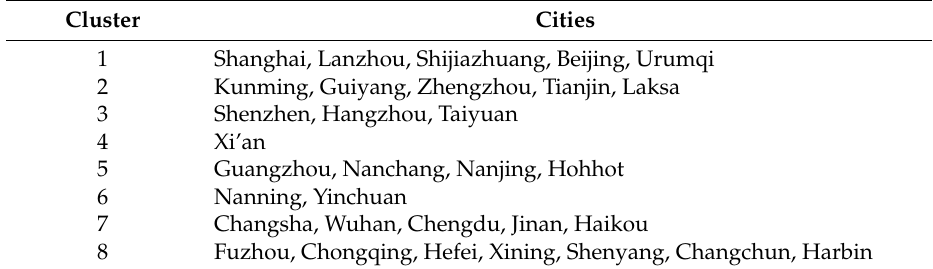
Table 3. Cities in each cluster using self-organizing map (SOM) with row normalization. Cluster